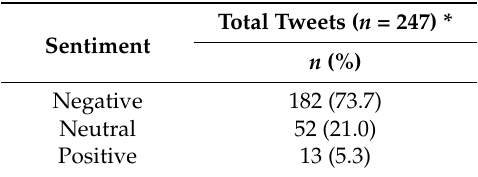
Table 3. Sentiment of